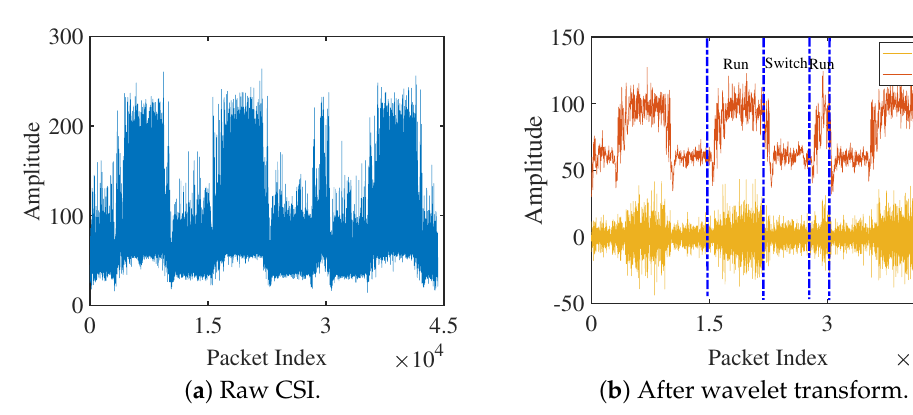
Figure 3. CSI segmentation of one